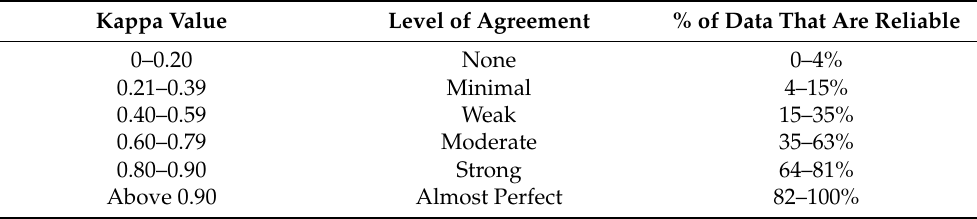
Table 11. Accuracy Assessment Calculation.